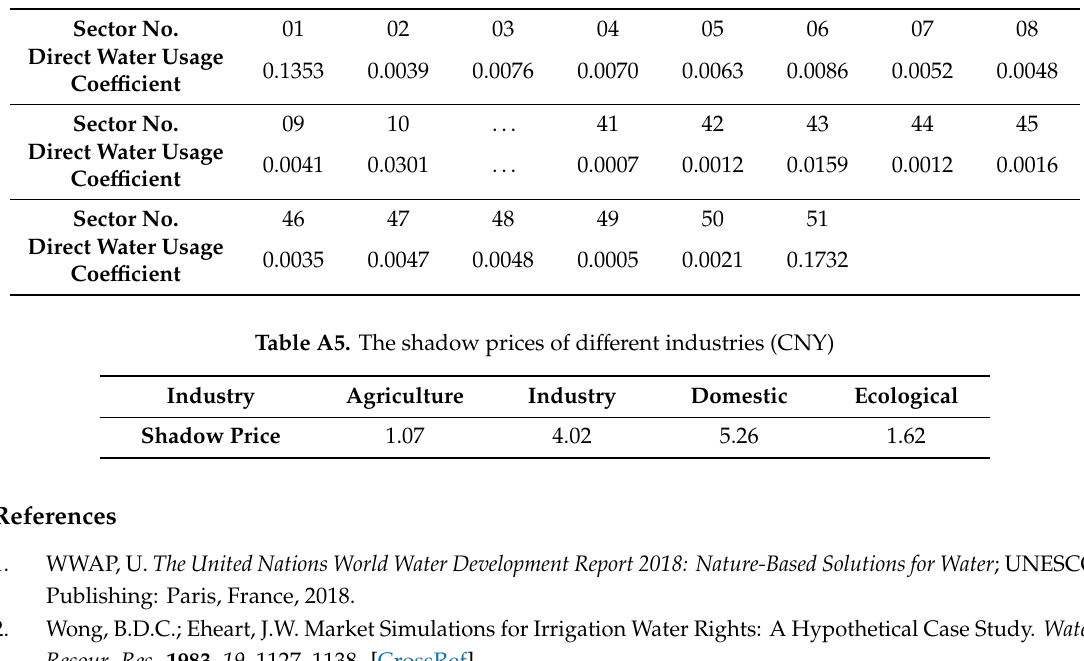
Figure A1. Concept diagram of water input and output table.